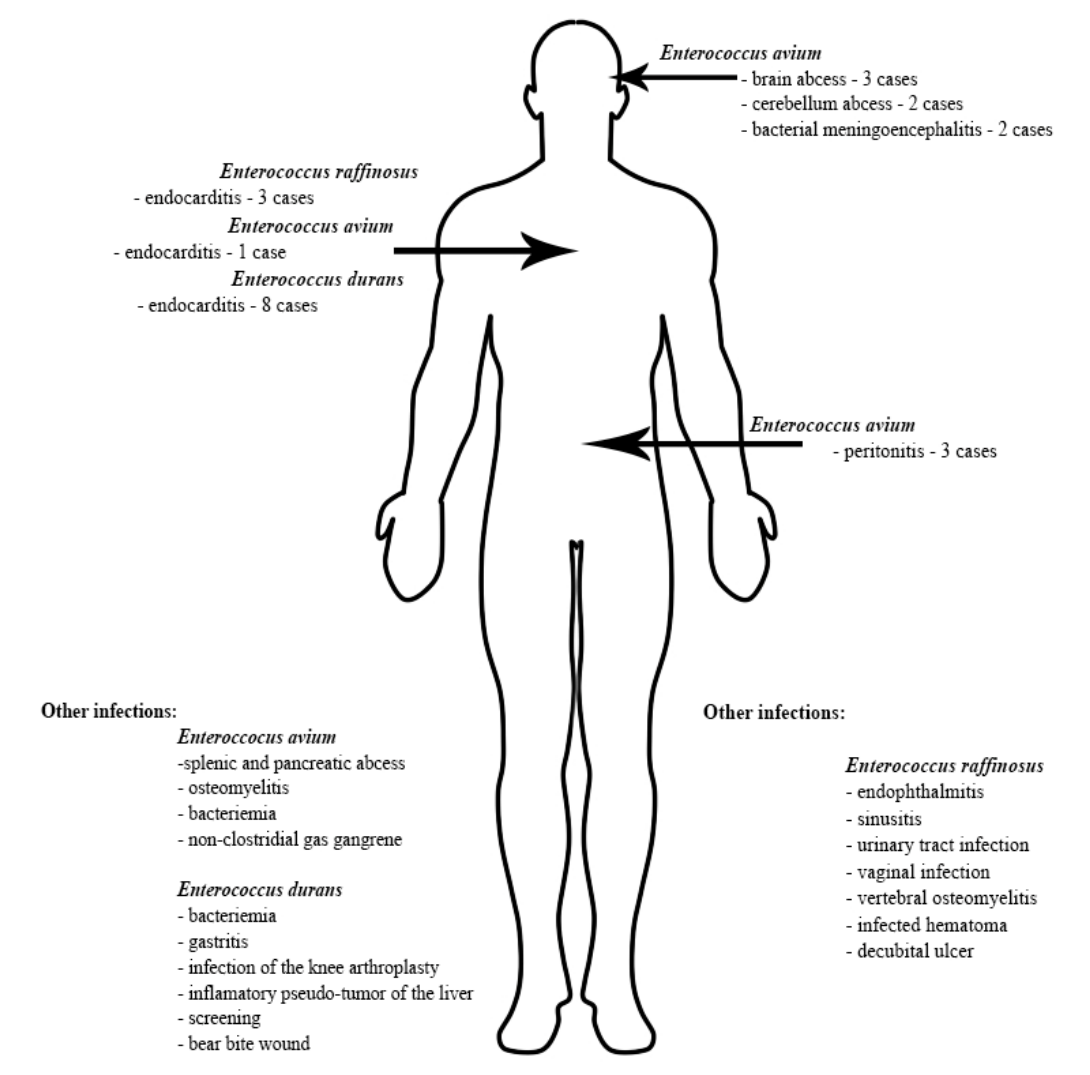
Figure 3. Infection localization of E. avium , E. raffinosus and E. durans [36–50,53–65,67–75].